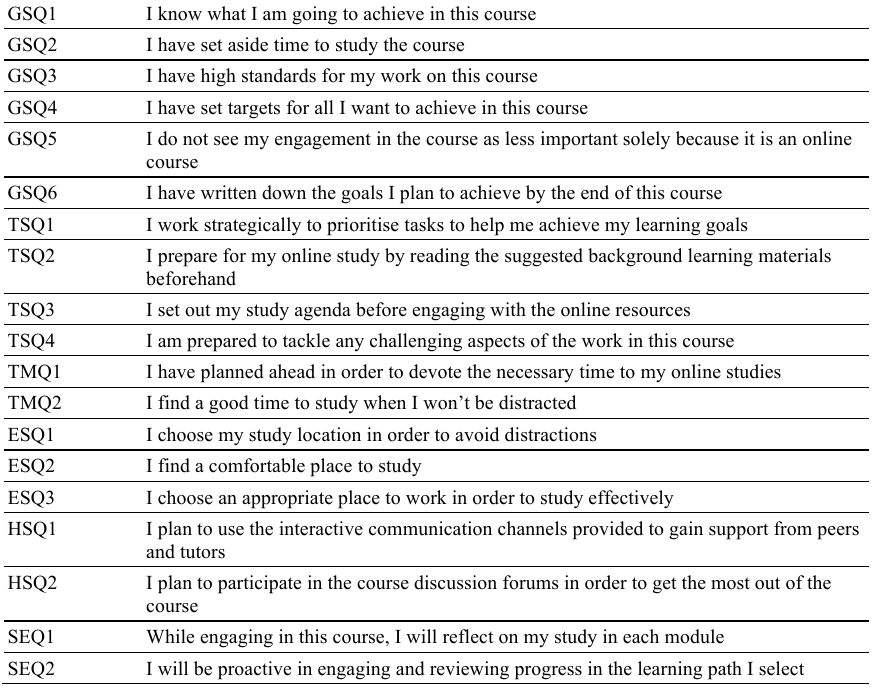
Table 1. MOSLQ survey